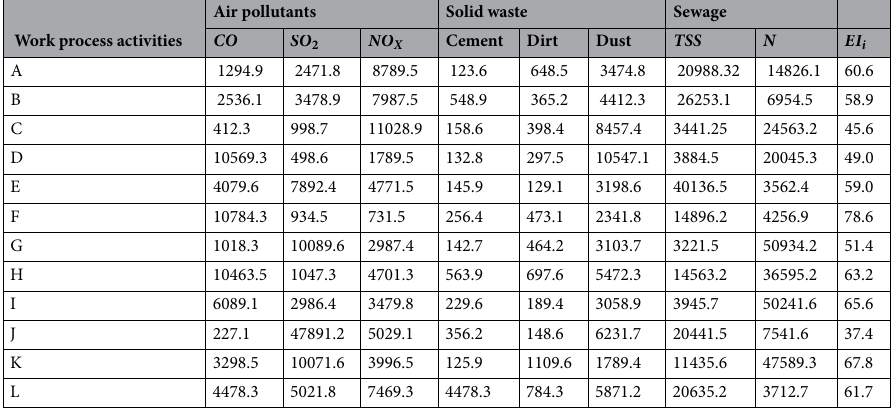
Table 2. Emissions of common hazardous pollutants.